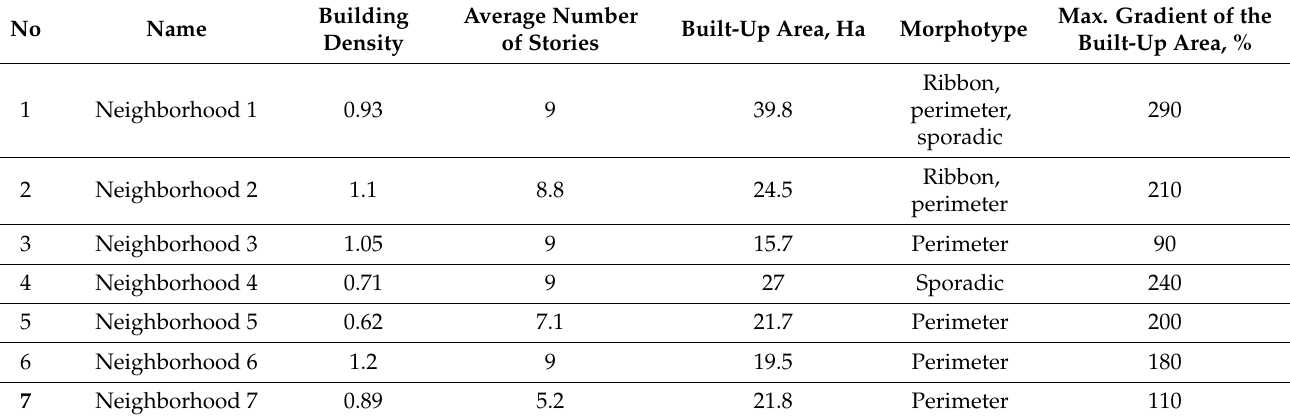
Table 2. Principal urban planning parameters of residential areas on the slopes of AZRF